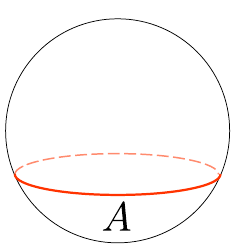
Figure 3. 1 / 8 BPS Wilson loop on S 2 . The Wilson loop (denoted by a thick red curve) divides the S 2 into two regions, one with area A and the other with area 4 π − A